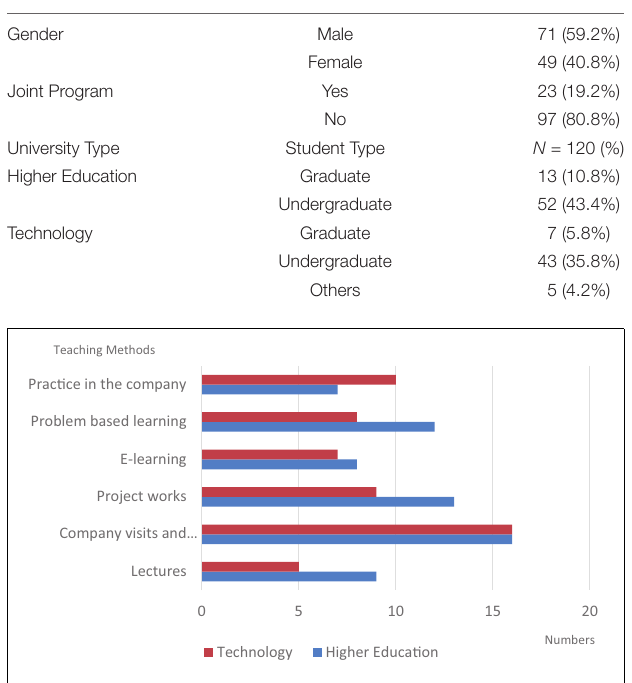
TABLE 2 | Descriptive analysis of respondents.